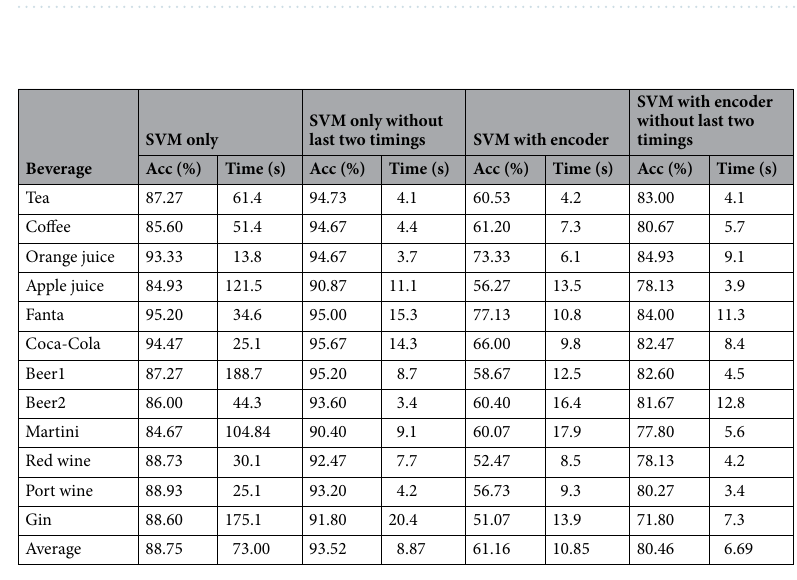
Table 3. Accuracies (average) for detecting aging of beverage stains and training time for training data set.